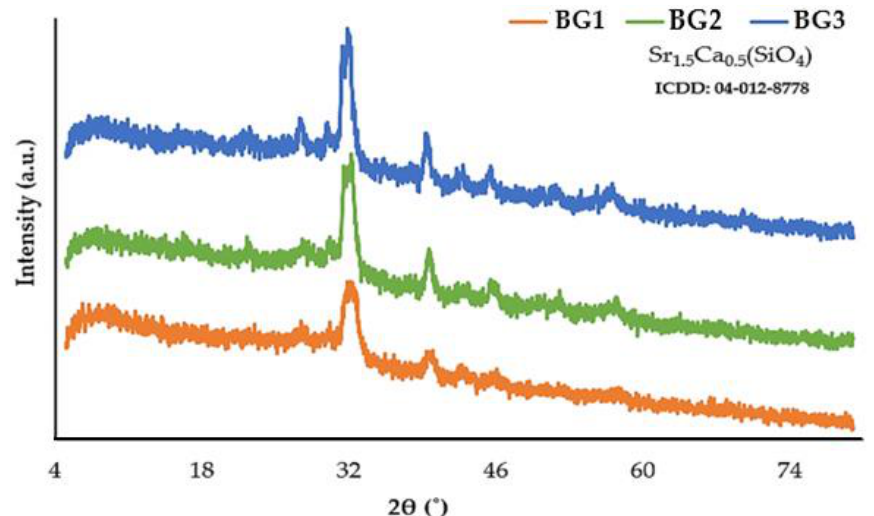
Figure 2. XRD patterns of samples BG1, BG2, and BG3 after calcination at 700 °C. The only crystalline phase identified is calcium strontium silicate (Sr 1.5 Ca 0.5 (SiO 4 )).